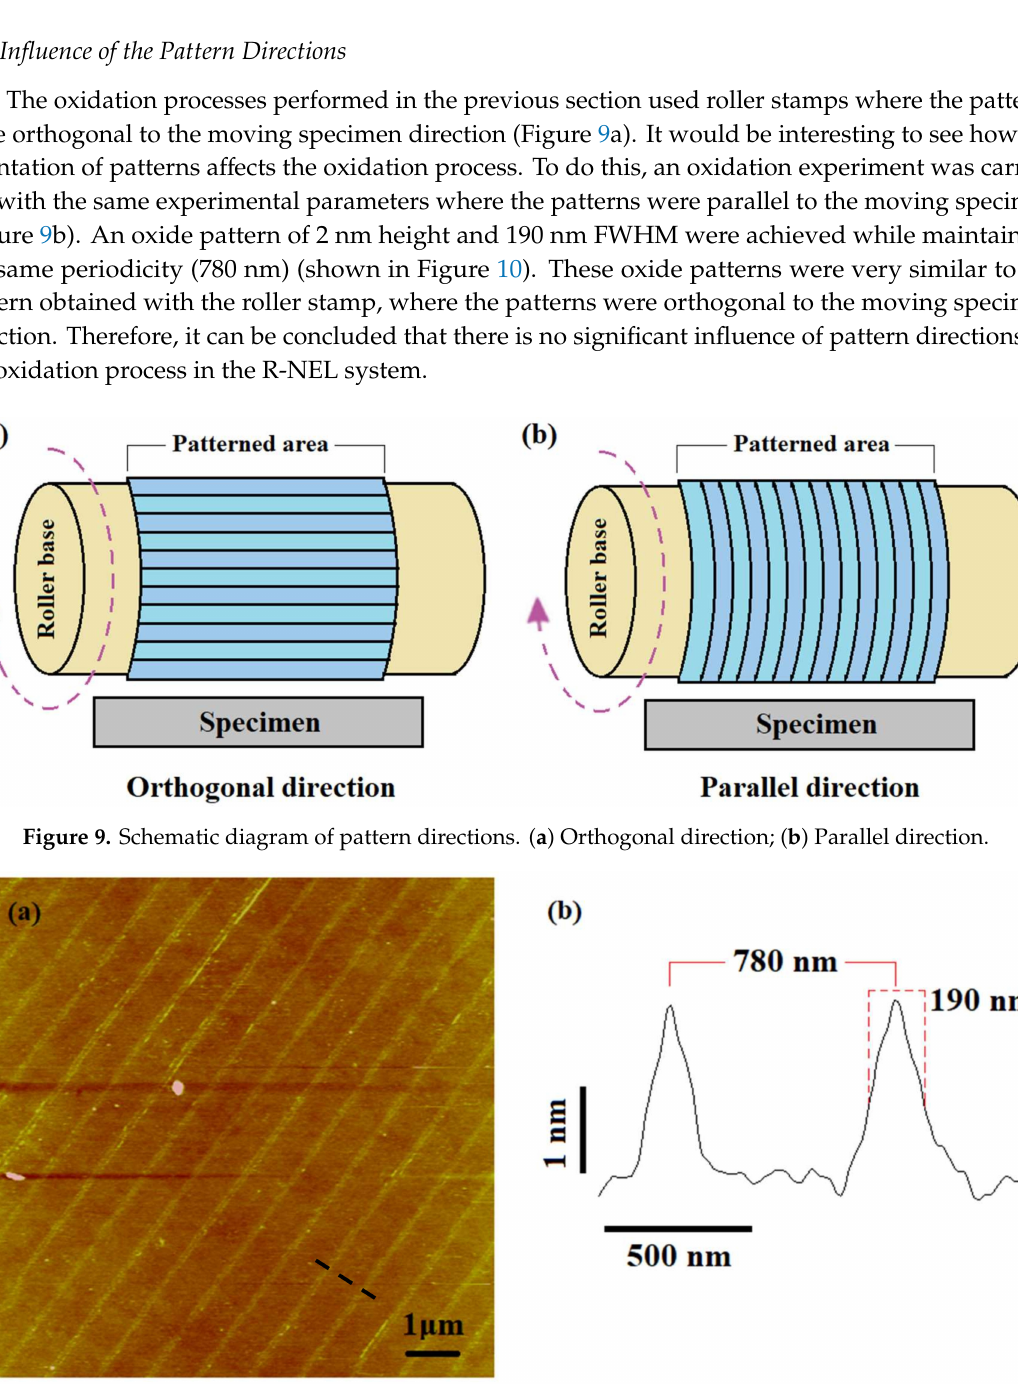
Figure 10. Parallel pattern direction. ( a ) AFM topography image of the oxide lines. ( b ) Profile of the lines marked in the image ( a